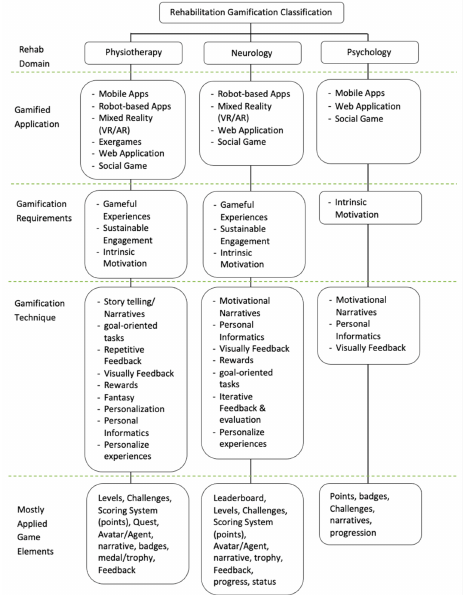
Figure 3. The Classification of gamification in